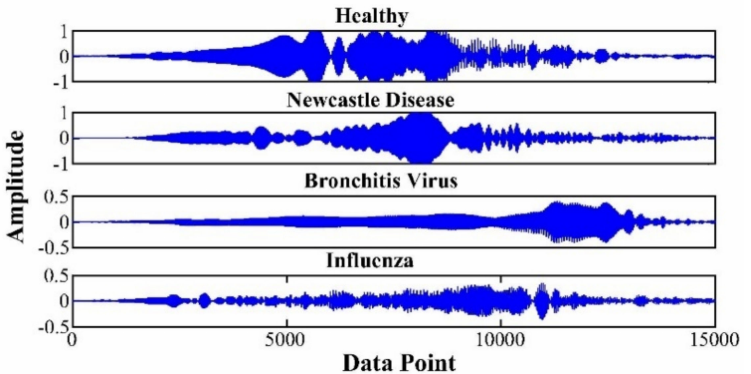
Figure 3. Sound time domain signals for four classes of chickens: healthy, infected Newcastle disease, bronchitis virus and avian influenza. Reprinted with permission from Ref.